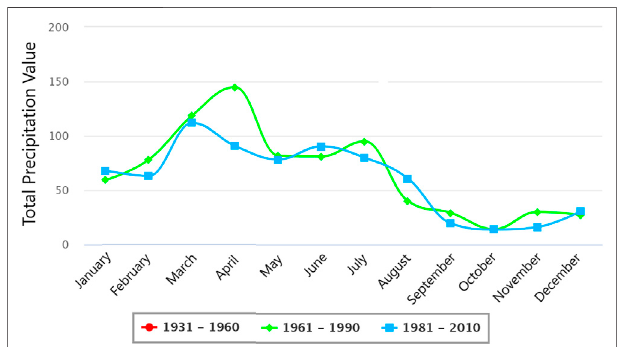
FIGURE 4 | Comparative graph of historical variations in accumulated precipitation (mm) in the Pernambuco State in three annual intervals of 30 years. Source: Adapted from INMET (2021).